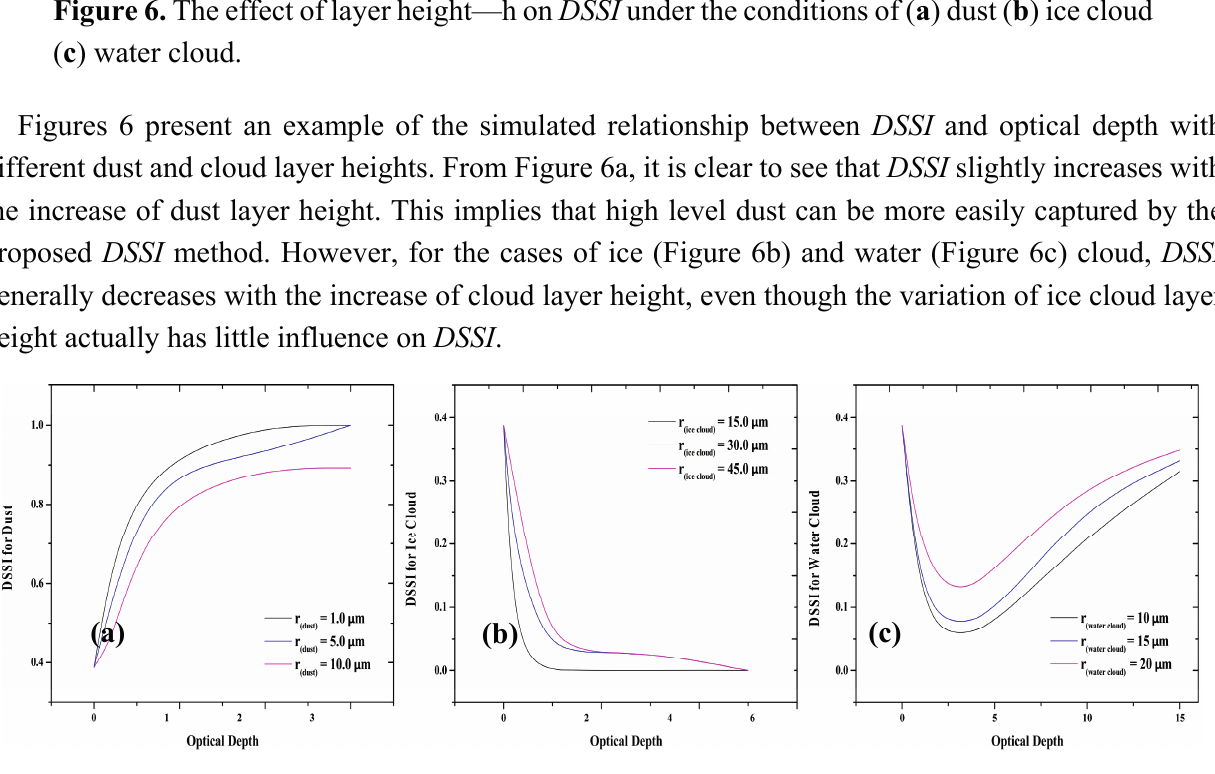
Figure 7. The effect of particle effective radius—r on DSSI under the conditions of ( a ) dust ( b ) ice cloud ( c ) water